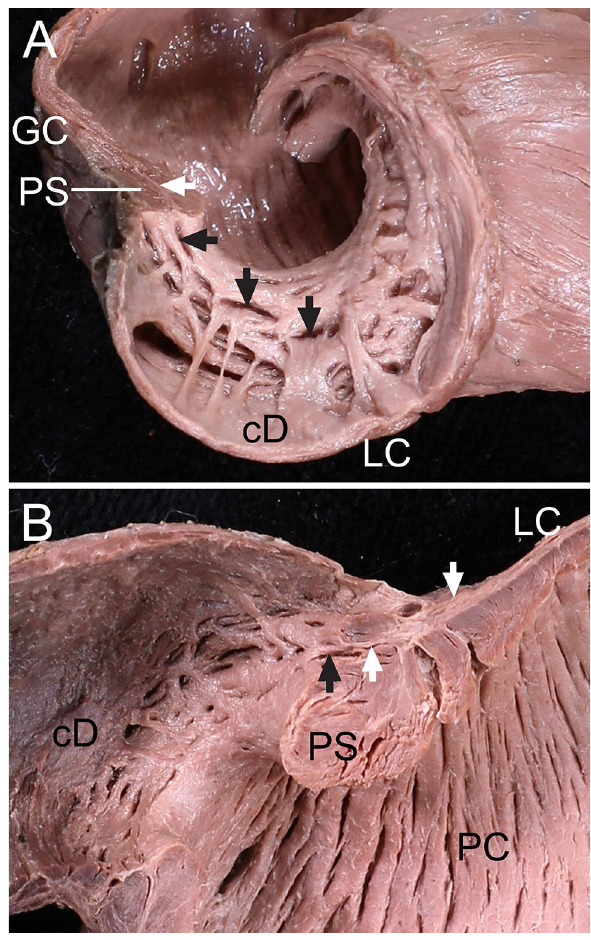
Figure 2. The pyloric sphincter (PS) divided according to the direction of the longitudinal bundles entering it. ( A ) Some longitudinal bundles (white arrow) divided the PS into several parts in a longitudinal section including the greater curvature (GC). The divided parts (black arrows) of the PS were not separated completely, but were connected to each other. ( B ) Some longitudinal bundles (white arrows) entering the PS were connected to the aboral circular bundles (black arrow) of the PS in a longitudinal section including the lesser curvature (LC) and GC. cD circular bundles of the